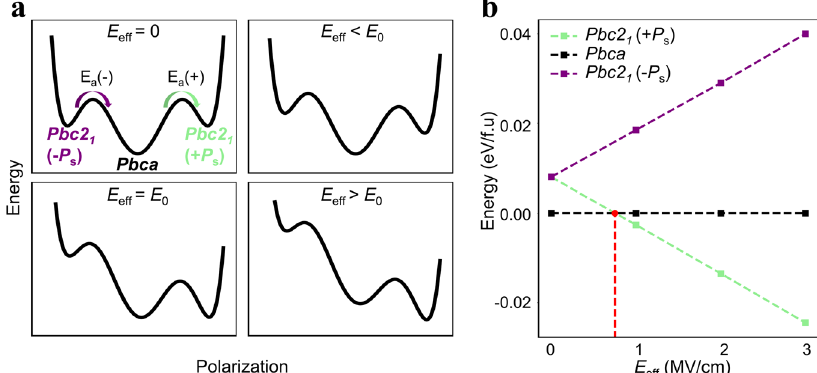
Fig. 5 Energy landscape and DFT calculations. a schematic diagrams of the energy landscape for the Pbca (center global minimum) and Pbc 2 1 (two local minima at fi nite P ) under zero E eff and non-zero E eff . b calculated energies of the Pbca , Pbc 2 1 ( – P s ), and Pbc 2 1 ( + P s ) as a function of E eff .